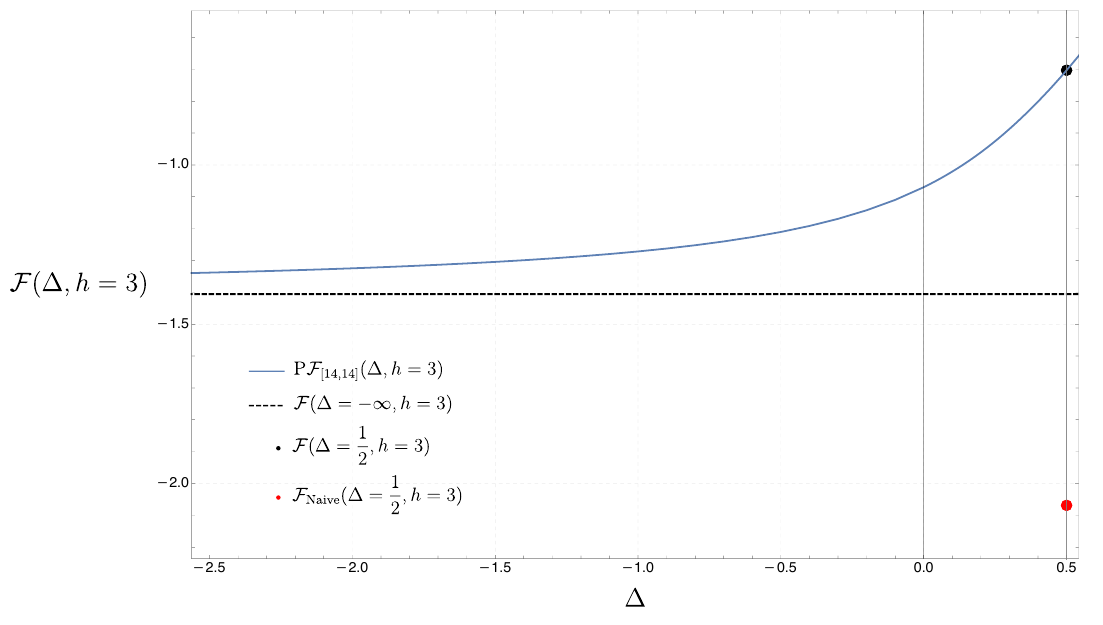
Figure 5 . Free energy as function of ∆ at fixed h = 3 . The red dot corresponds to the (wrong) free energy one would get by setting ∆ = 1 / 2 in the kernel appearing in (3.8). The black dot is the correct value found using